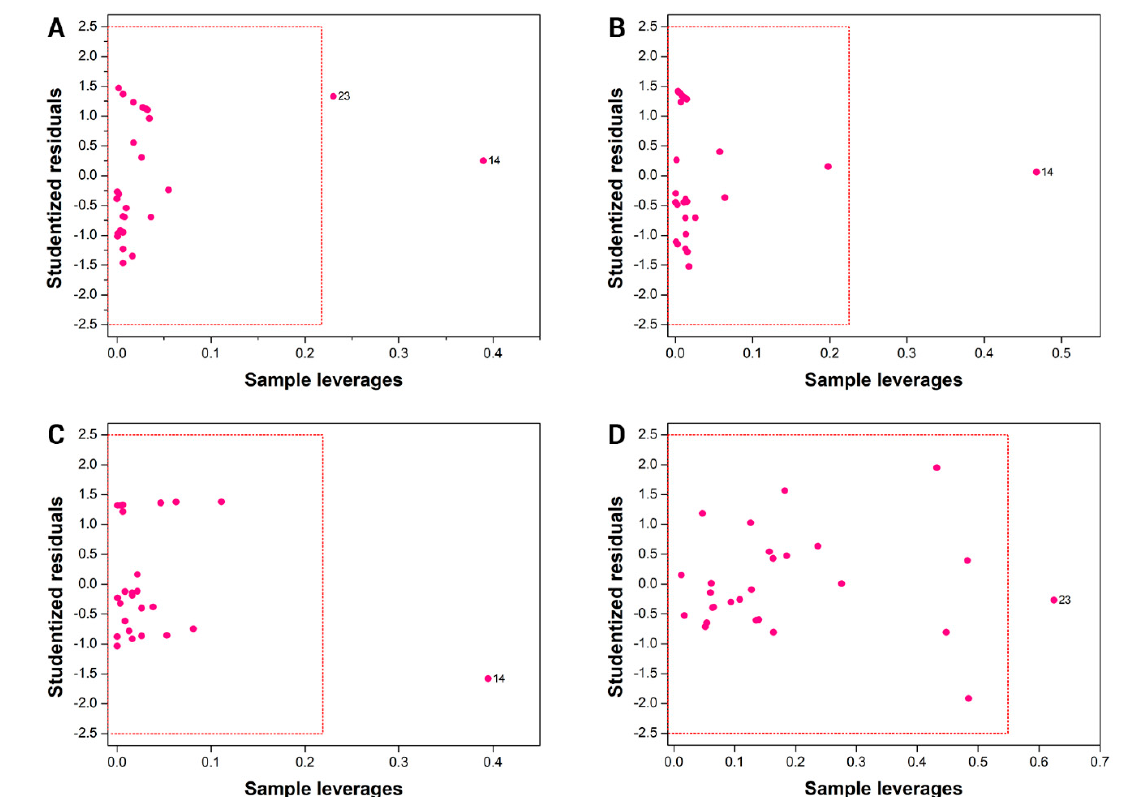
Figure 4. Applicability domain for the final QSAR models. ( A ) AutoQSAR; ( B ) HQSAR; ( C ) CoMFA; and ( D ) CoMSIA.